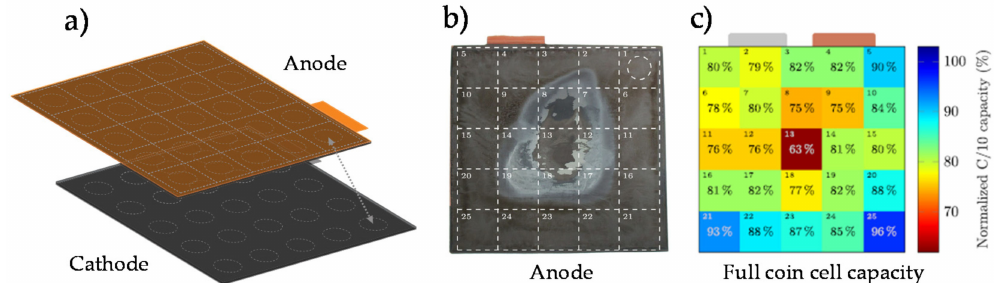
Figure 8. Spatially resolved capacity measurement with coin cells: ( a ) Shows schematic of the location of the samples; ( b ) Shows one anode sheet and sample locations; ( c ) Heat map with normalized C/10 capacity with location on the electrodes. Reproduced and modified with permission from [20] Copyright 2020, Elsevier.